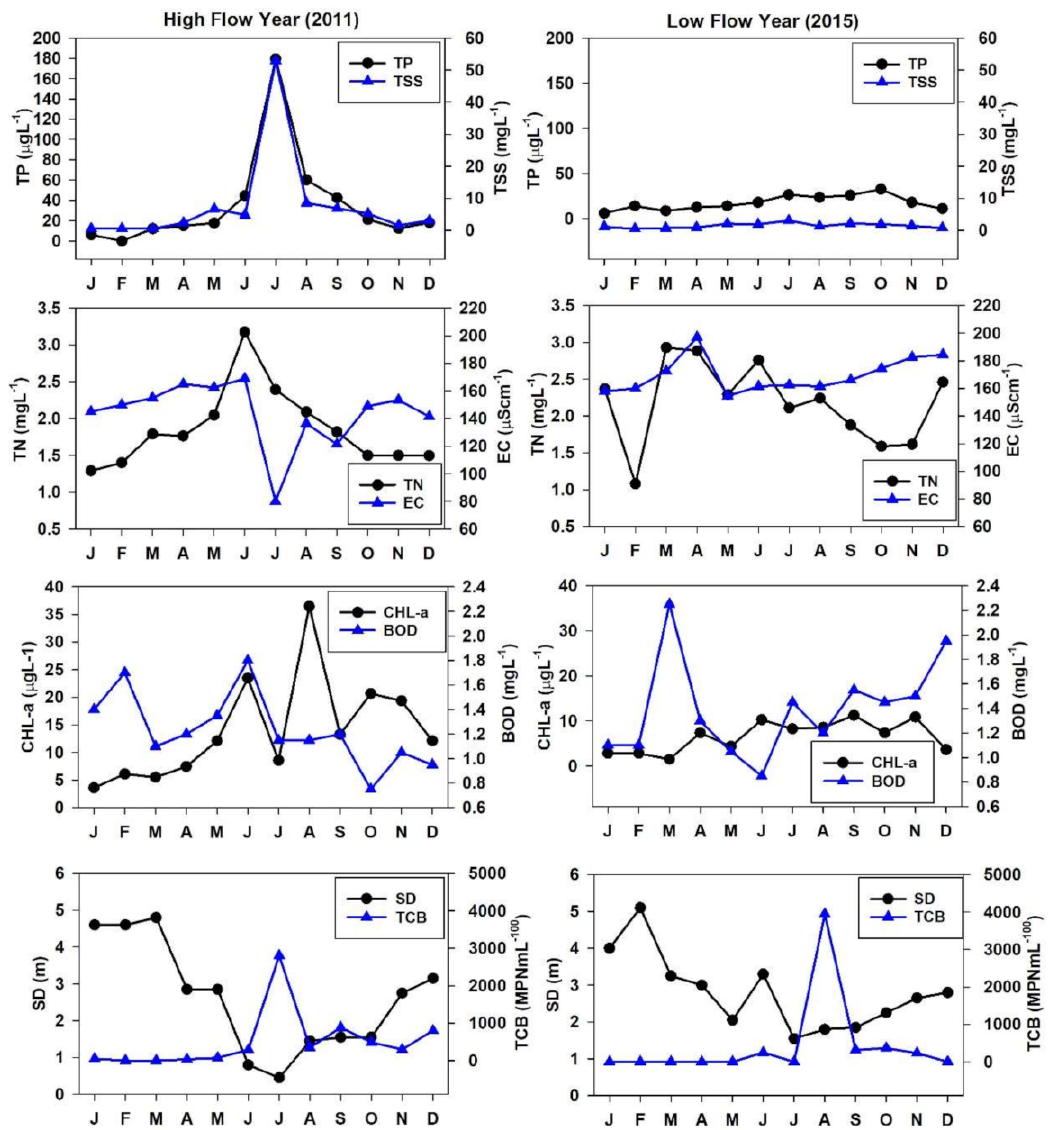
Figure 4. Monthly variations of selected water quality parameters during the high (2011) and low (2015) flow years. TP: total phosphorus, TSS: total suspended solids, TN: total nitrogen, EC: electrical conductivity, CHL-a: chlorophyll-a, BOD: biological oxygen demand, SD: Secchi depth, TCB: total coliform